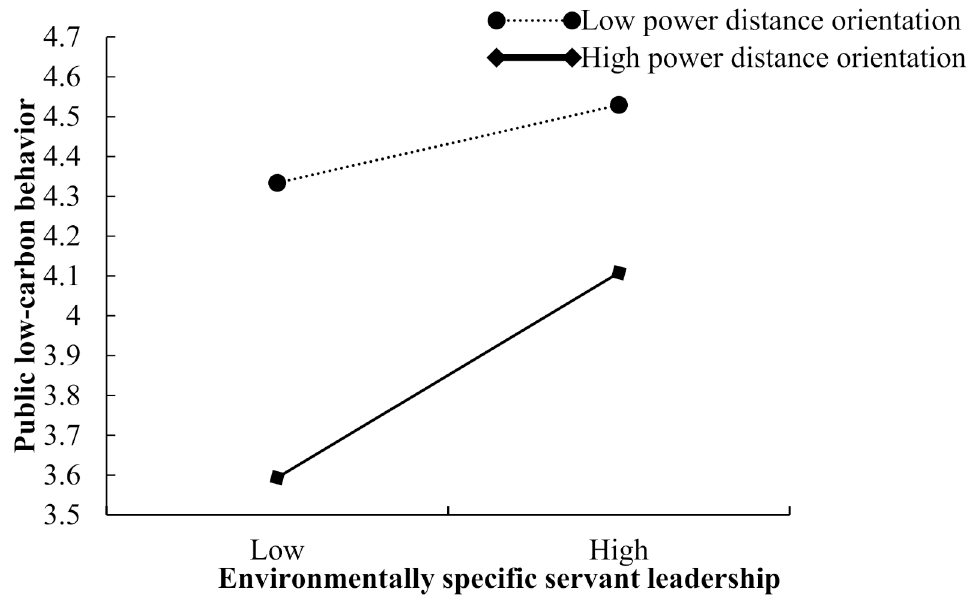
Figure 4. The moderating effect of power distance orientation on the relationship between environ- mentally specific servant leadership and public low-carbon